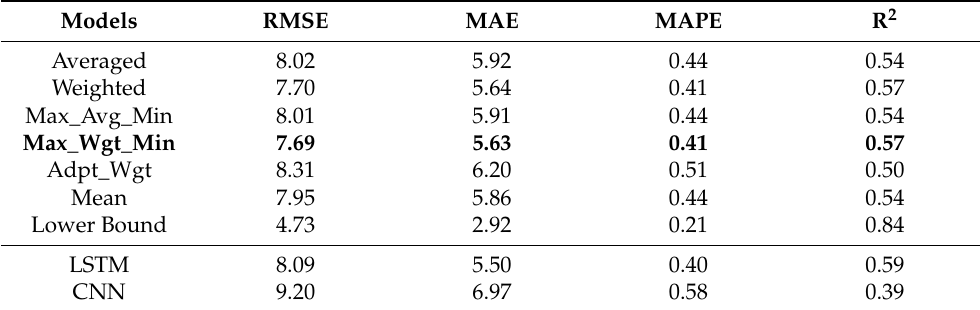
Table 7. Three-year forecasting performance obtained by various multi-model strategies and deep- learning